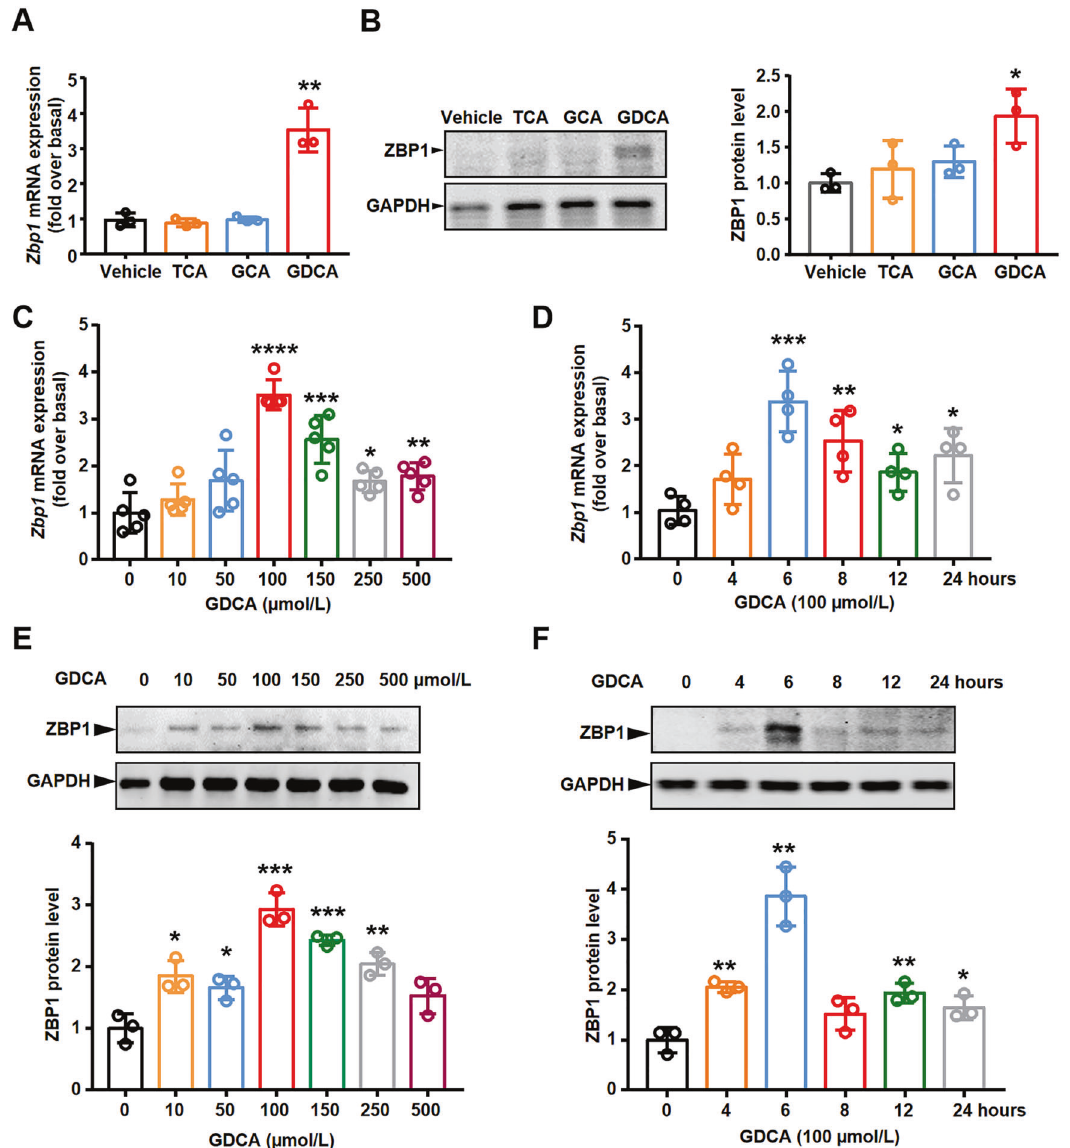
hydrate (GCA), and sodium glycodeoxycholate (GDCA) for 6 h, respectively. C Zbp1 mRNA level was measured by qRT-PCR in mouse BMDMs treated with the indicated concentrations of GDCA for 6 h. D Zbp1 mRNA level was measured by qRT-PCR in mouse BMDMs treated with 100 μ mol/L GDCA for different time points. E , F ZBP1 protein level was measured in mouse BMDMs treated with the indicated concentrations of GDCA ( E ) or different time points ( F ). All results were con fi rmed by at least three independent experiments. Data are presented as the mean ± SEM. * p < 0.05, ** p < 0.01, *** p < 0.001, **** p < 0.0001 (versus